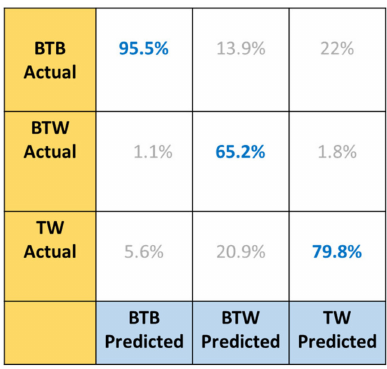
Figure 15. The testing performance of the DBNs built using 21 inputs, 50 neurons in the first hidden layer, 50 neurons in the second hidden layer, 50 neurons in the third hidden layer, and 3 output